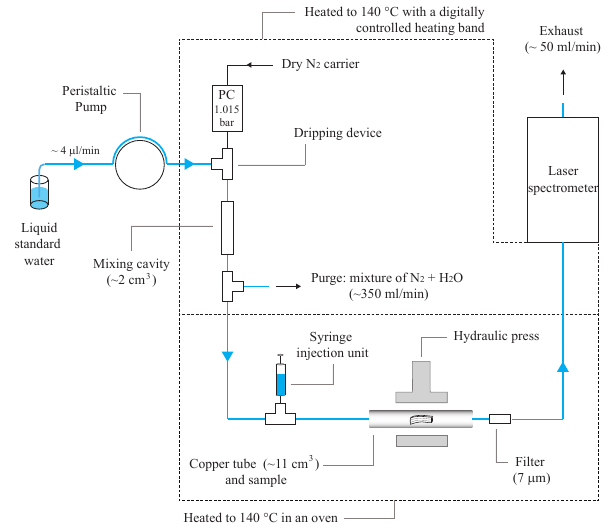
Figure 1. Diagram of the speleothem fluid inclusions water extrac- tion